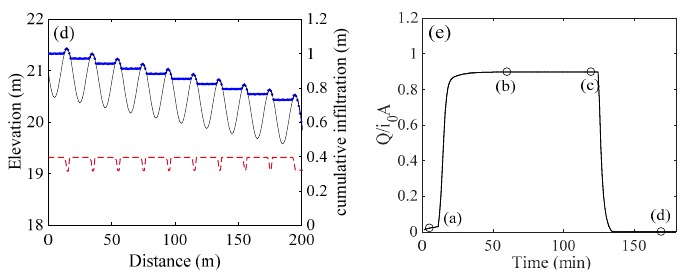
Figure 3. ( a – d ) Computed water surface profile and accumulated infiltration at ( a ) t = 5 min, ( b ) t = 60 min, ( c ) t = 120 min, and ( d ) t = 170 min. ( e ) Hydrographs at the downstream boundary.